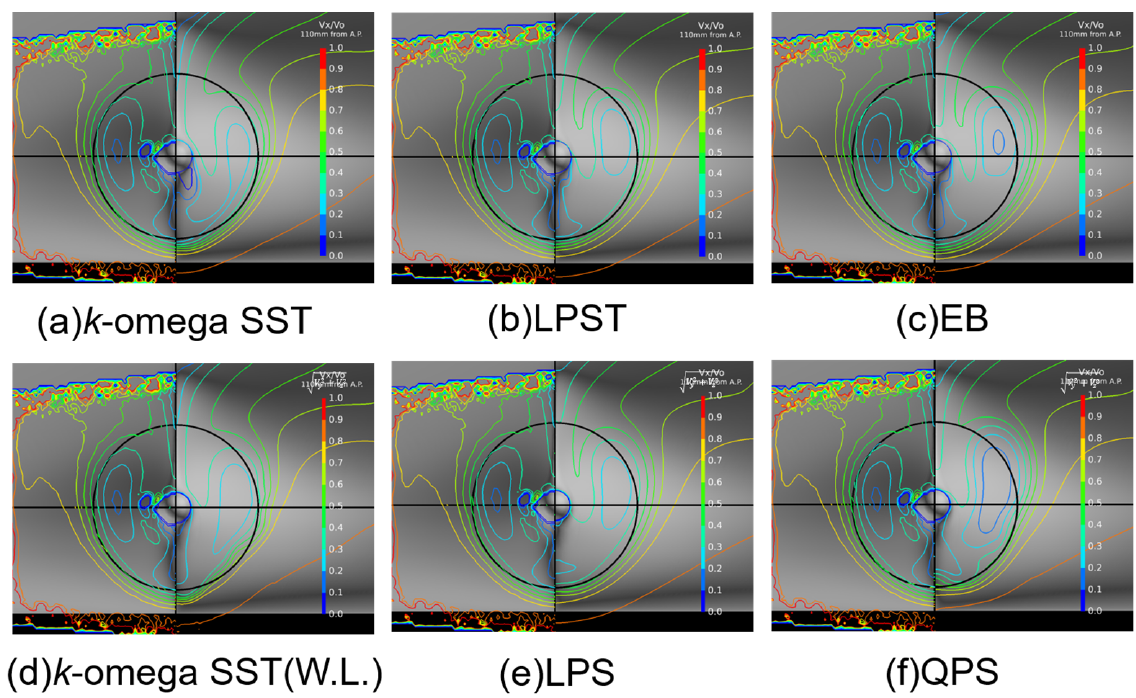
Figure 7. Distribution of longitudinal velocity of SPIV (Left) and CFD (Right) at 110 mm from AP to bow side. ( a ) k –omega SST ( b ) LPST ( c ) EB ( d ) k –omega SST (W.L.) ( e ) LPS ( f ) QPS